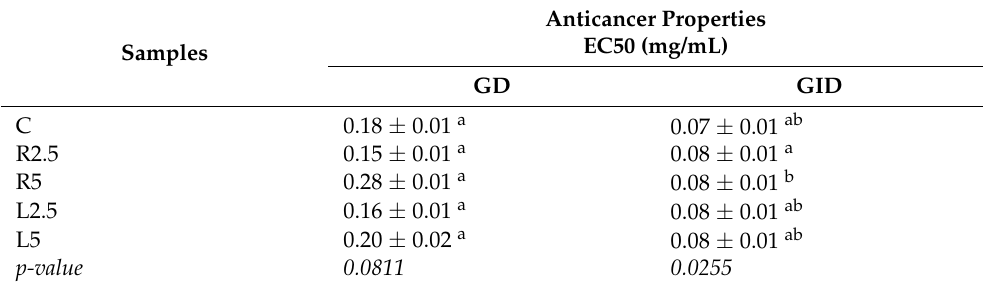
Table 6. Anticancer properties of pasta supplemented with dried Reishi and Lion’s Mane mushrooms.